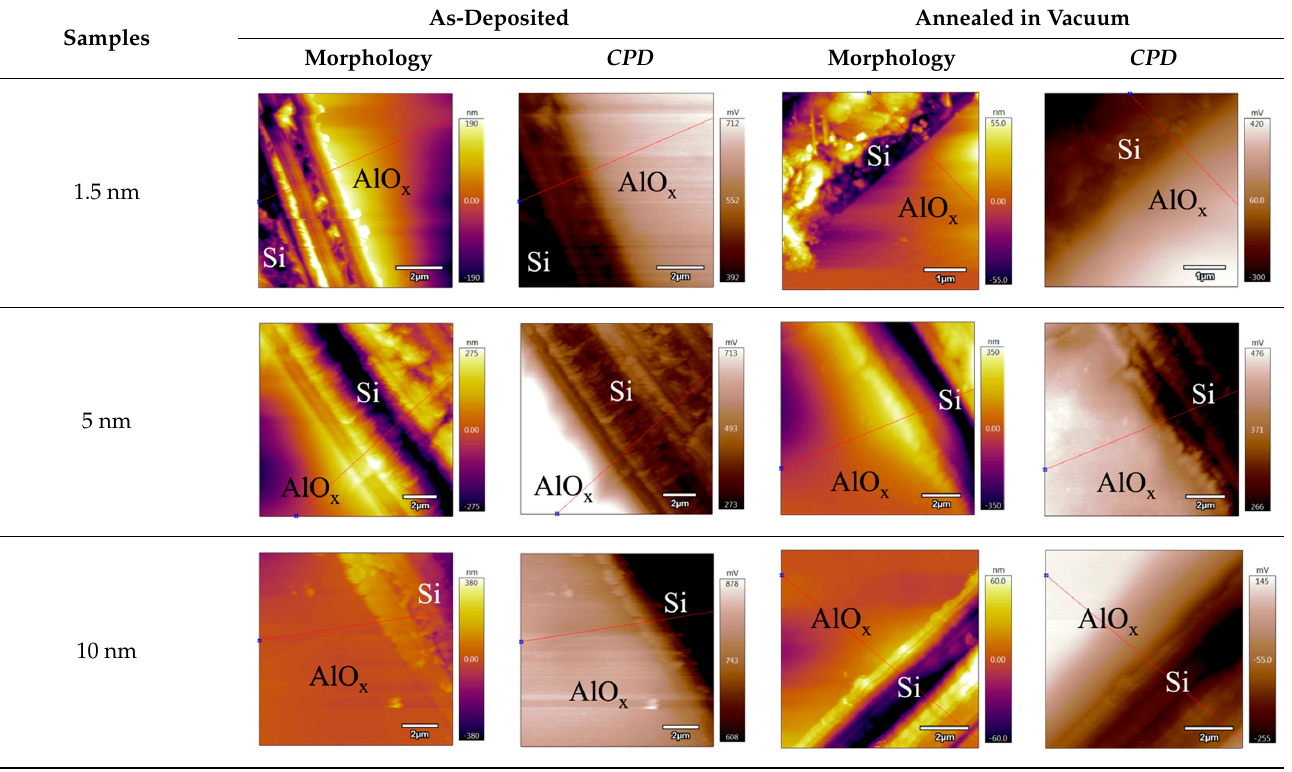
Table 2. AFM (morphology) and KPFM ( CPD ) mapping of six AlO x samples: as-deposited and annealed in vacuum for three different AlO x